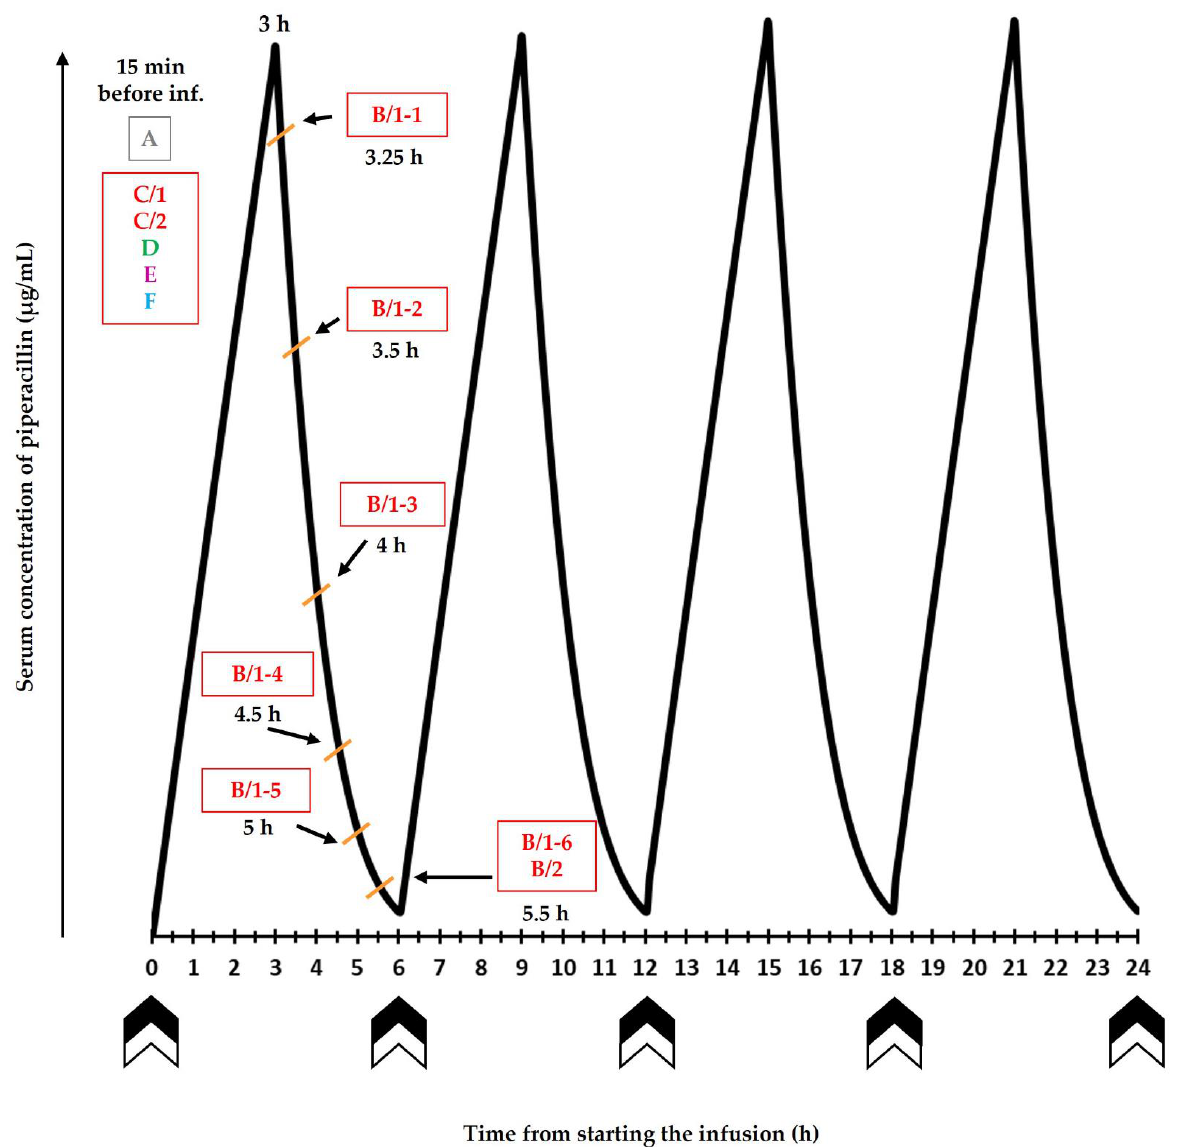
Figure 2. Protocol of sampling showing the first 24 h of treatment with piperacillin/tazobactam and with hydrocortisone. The same protocol is applied up to 5 days following admission to the intensive care unit. Drug administration (piperacillin/tazobactam and hydrocortisone) is indicated by double arrow ( ). Sample and aliquot identifiers are displayed in colored boxes.